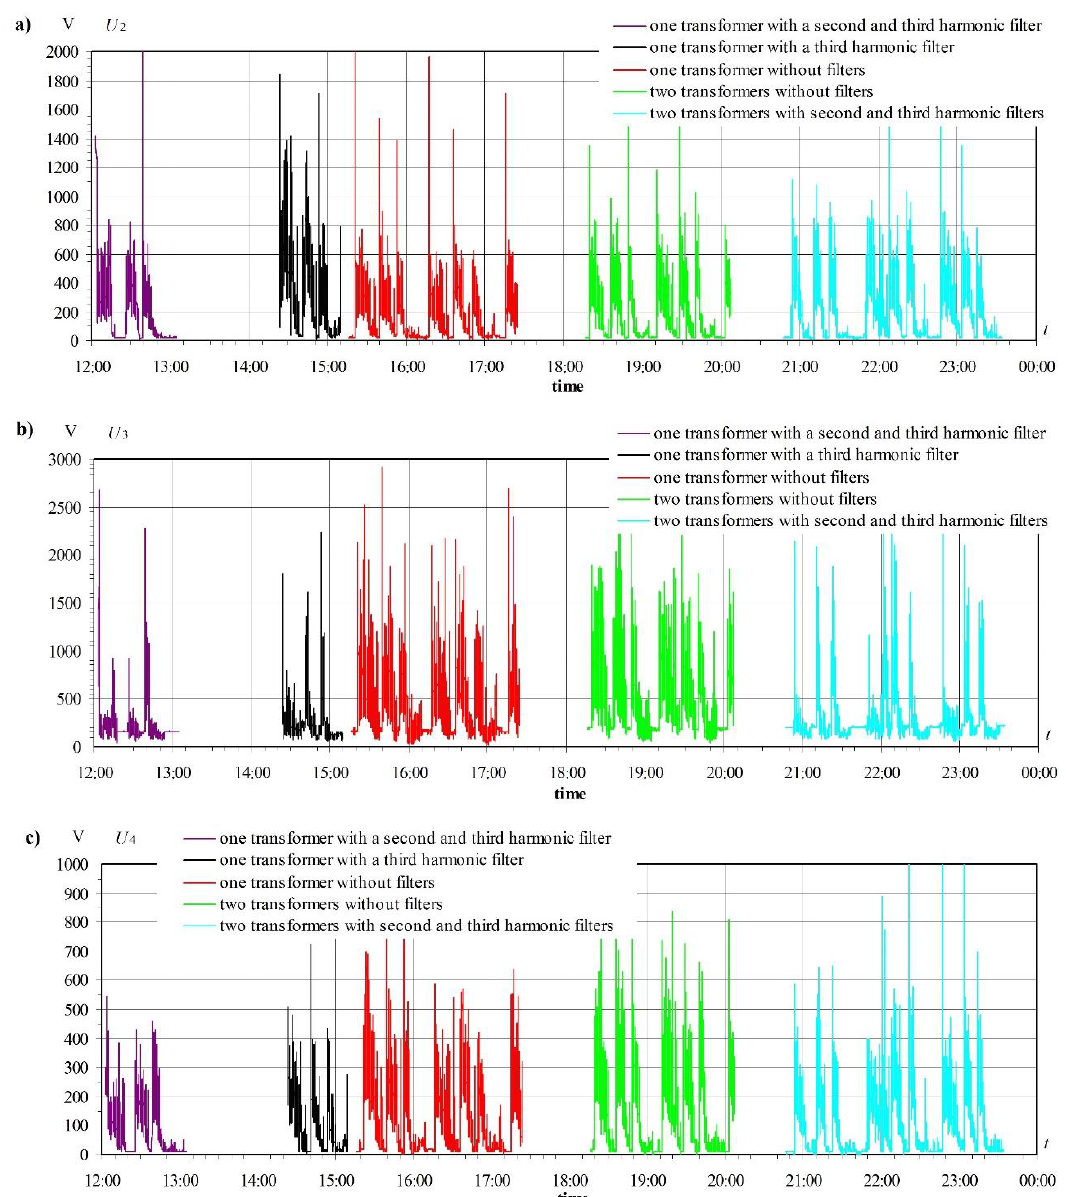
Figure 11. Variations in the RMS values in phase L1 in the transformer field on a 110 kV busbar. ( a ) Second harmonic voltage. ( b ) Third harmonic voltage. ( c ) Fourth harmonic voltage.